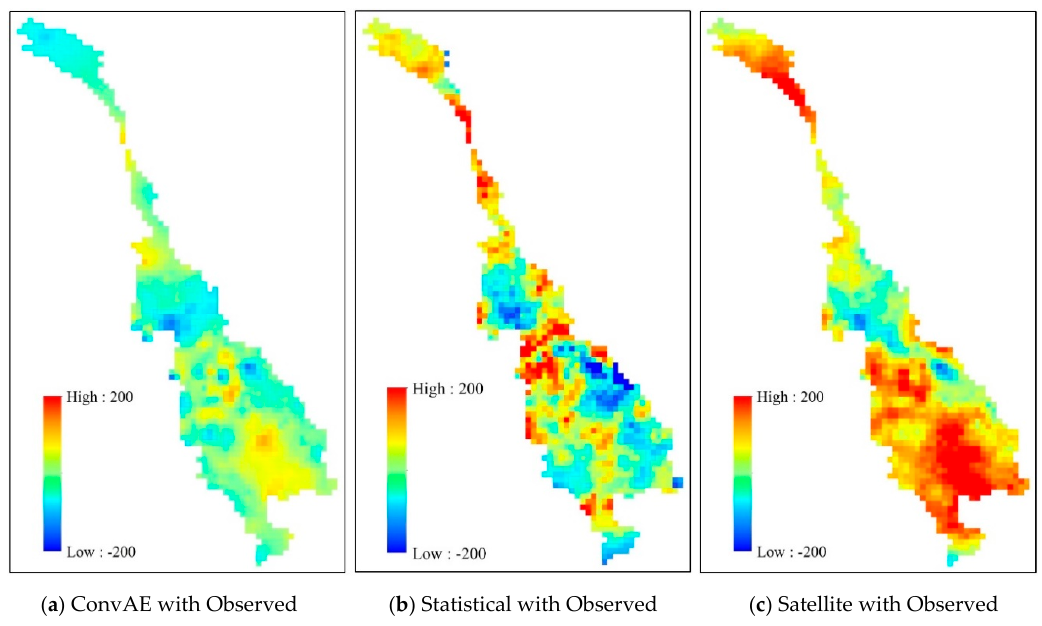
Figure 17. Spatial bias distribution pattern of the precipitation products compared to the observed data in August 2014.